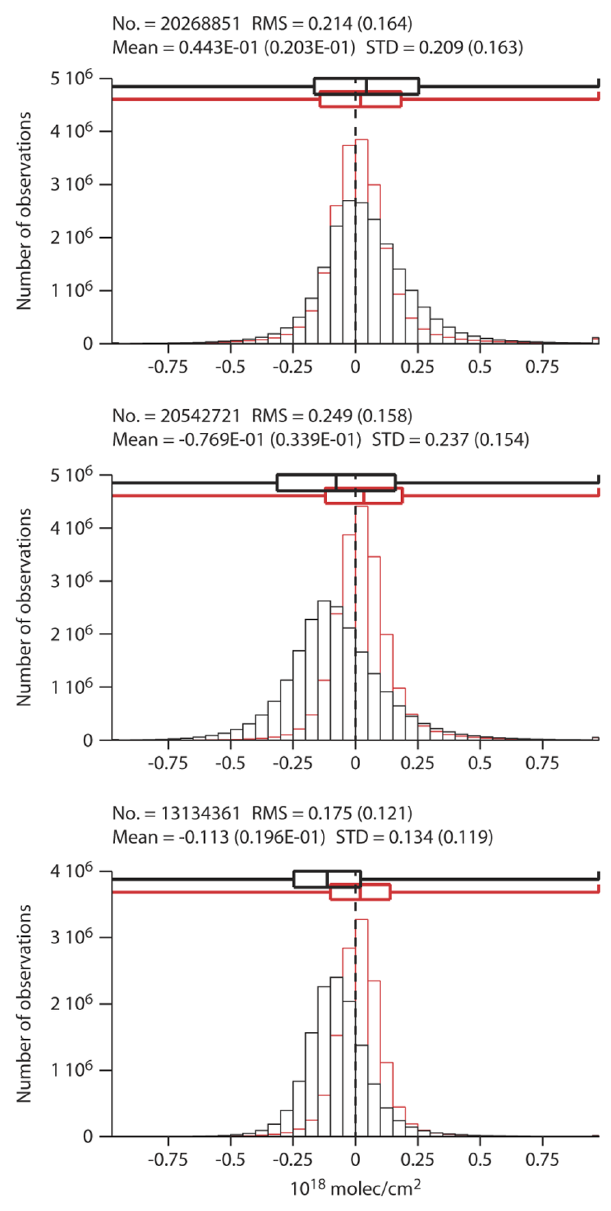
Figure 2. Histograms of MOPITT TCCO analysis departures (ob- servation minus analysis) for CIFS-AN (red) and CIFS-CTRL (black) for 2008 averaged over the NH (90–20 ◦ N), the trop- ics (20 ◦ N–20 ◦ S) and the SH (20–90 ◦ S) for all good data in 10 18 moleculescm − 2 . Also shown above the panels are the num- ber of observations that make up the average, as well as the mean, RMS and SD of the departures with values for REAN in